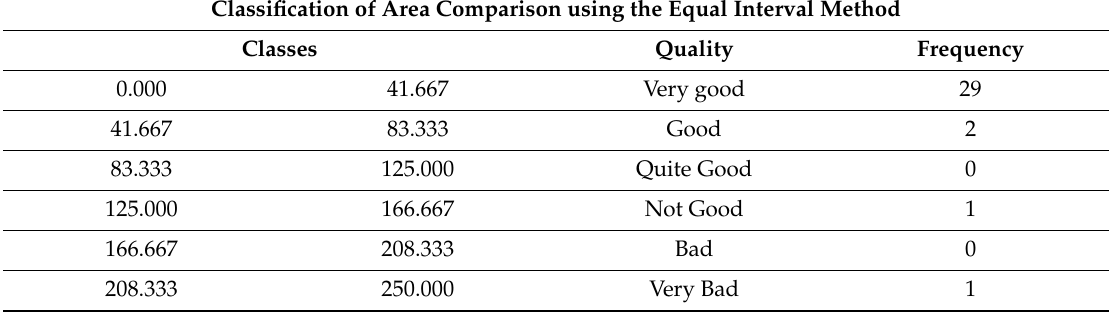
Table 4. Classification of area comparison in Tanggamus using the equal interval .